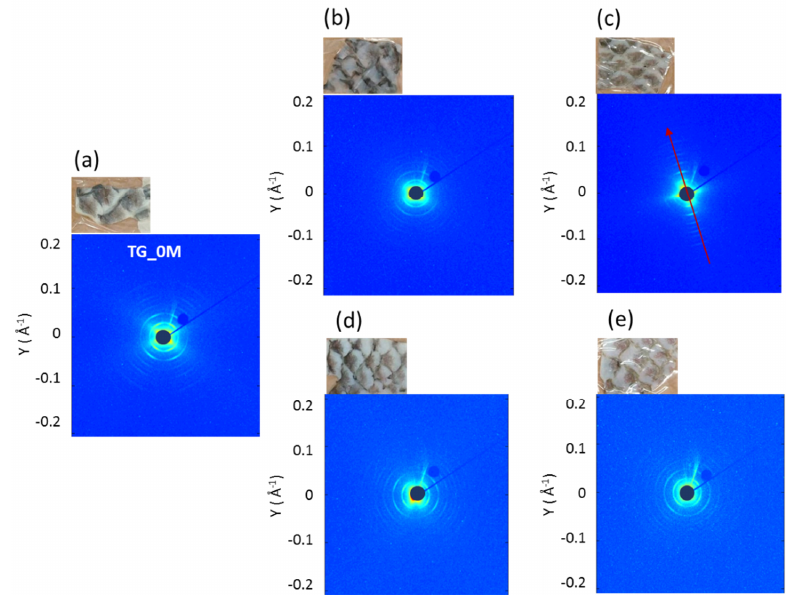
Figure 4. Two-dimensional SAXS diffraction patterns of Tilapia skin from ( a ) the control fish at time point 0 (TG_0M), fish fed for ( b ) two months (TG_2M_CTRL), and ( c ) four months (TG_4M_CTRL) with conventional feed; fish fed for ( d ) two months (TG_2M_TRAT) and ( e ) four months (TG_4M_TRAT) with collagen nutritional supplementation. ( c ) The red arrow shows the meridional direction, the fiber axis, and the red circle marks the fiber-like diffraction signal. Despite this, the typical electron density distribution along the collagen fibrils that gives rise to the SAXS diffraction pattern with a series of 66 ± 2 nm-spaced fringes is ob- served in fish skin of fish fed a conventional diet (Figure 5, black profile). A slight differ- ence in fibril spacing is visible in the fish skin of fish fed a collagen-rich diet (d-spacing = 65 nm ± 2 nm), showing that the fibril spacing coincides within the estimated errors. This evidence highlights that despite the fact that the fibrils are randomly oriented in the space, the fibrillary banding given by the molecular gap-overlap zones within the nanometric structure is still present.